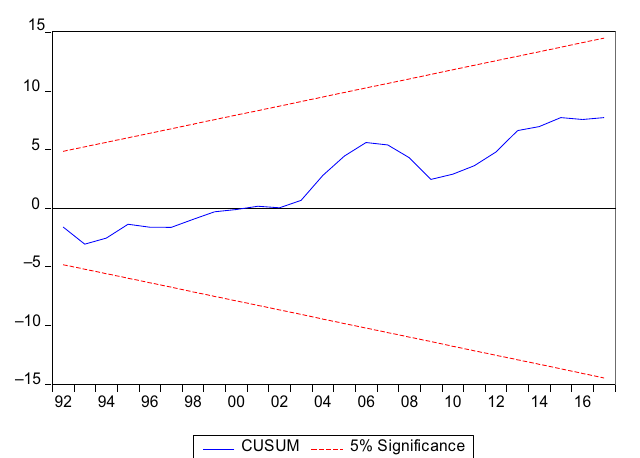
Figure 6. Plot of CUSUM test (Model